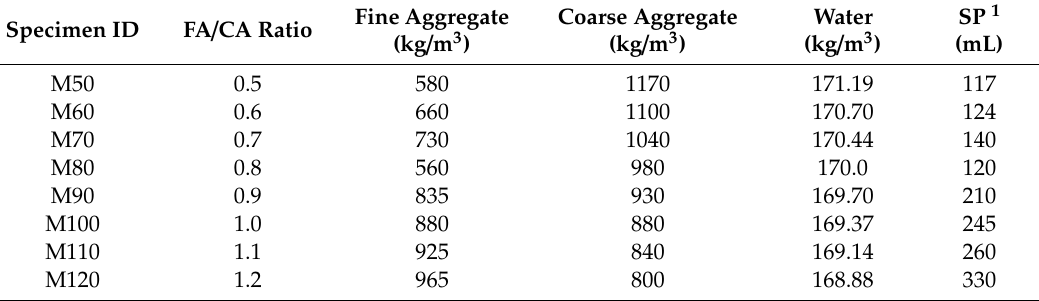
Table 3. Mixes proportions for SFRC (steel fiber reinforced concrete)